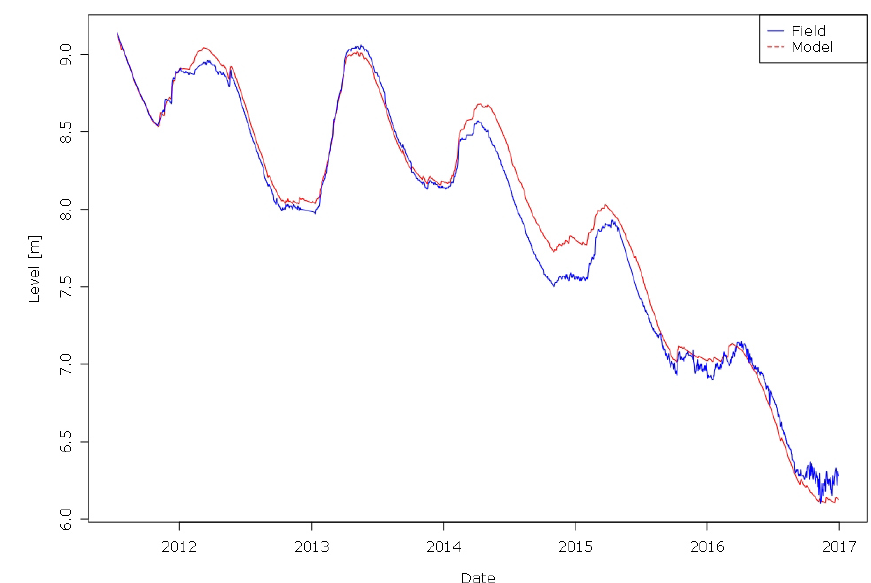
Figure 5. Observed (blue) and simulated (red) lake level of lake Baratz.